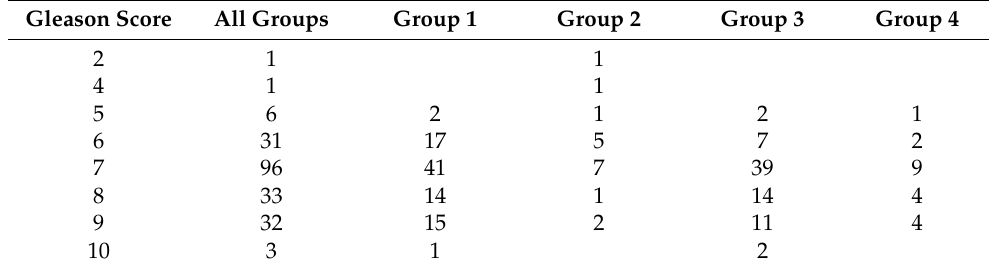
Table 3. Characteristics of Gleason